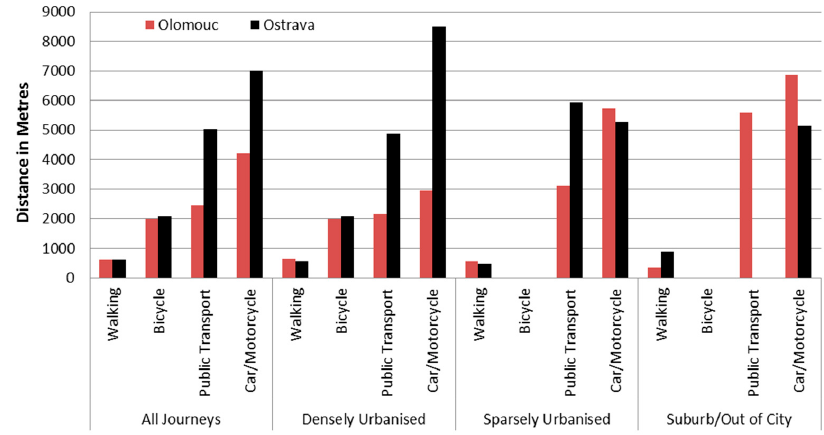
Figure 3. Average route distance according to the degree of urbanisation and mode of transport in Olomouc and Ostrava.